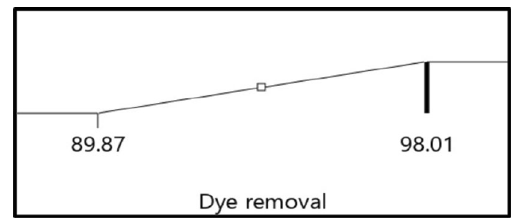
Fig. 24 Desirability ramp for the numerical optimization of